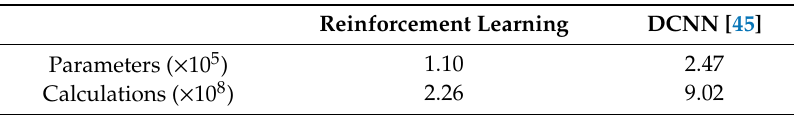
Table 3. Comparison of the computational complexity between the reinforcement learning model proposed in this study and DCNN model